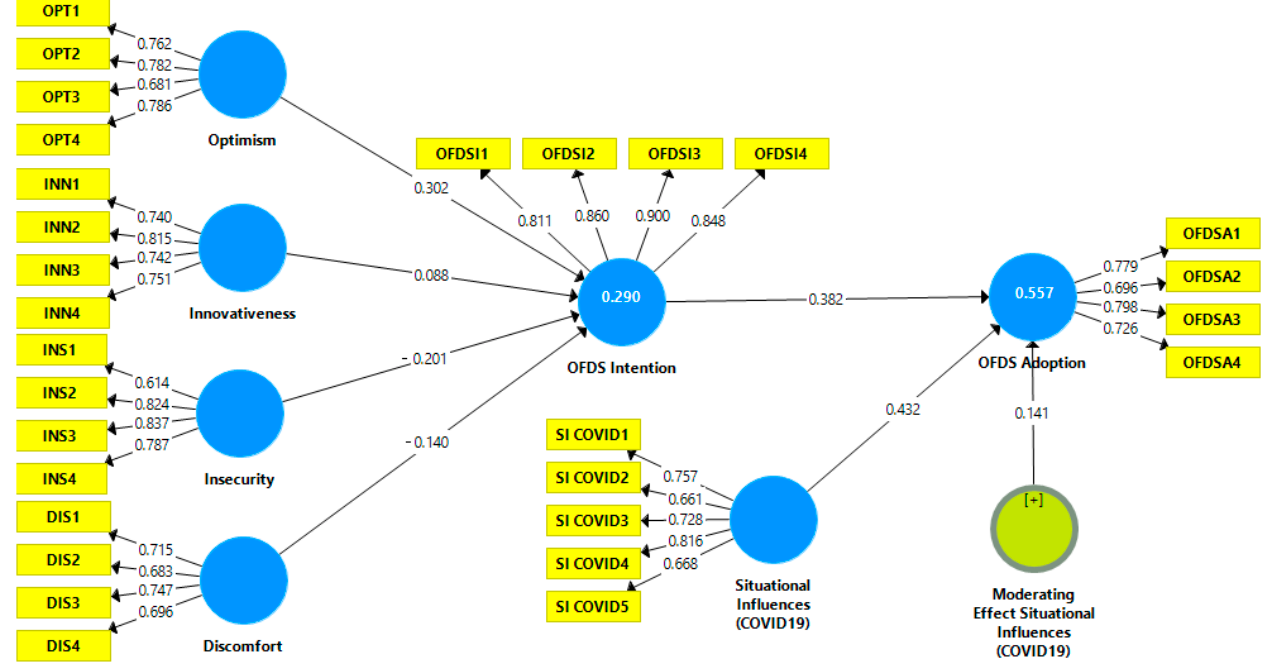
Figure 2. Moderating effect model (PLS-algorithm).